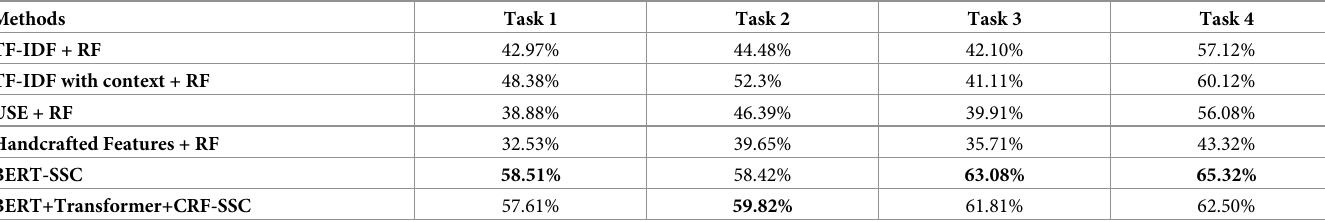
Table 8. Overall accuracy figures on the initial four tasks for the different baseline